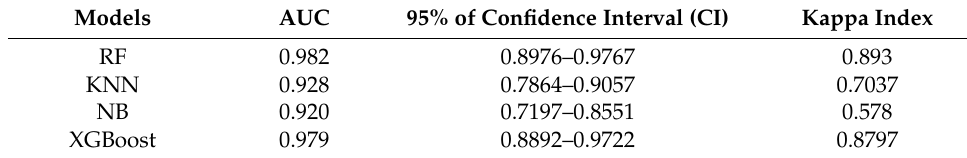
Table 5. AUC and Kappa index for the